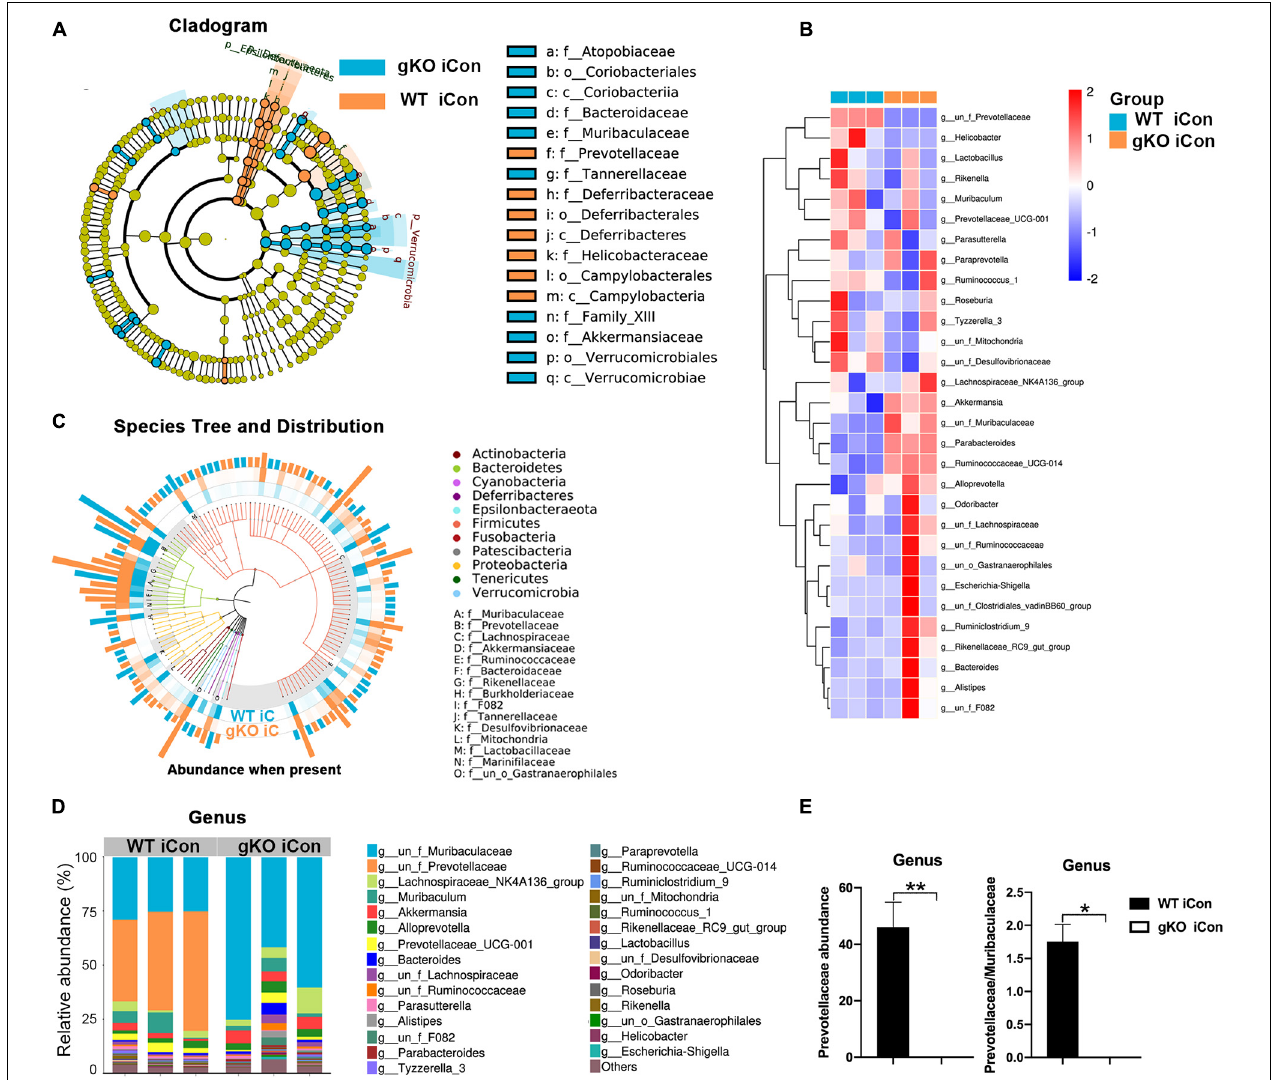
FIGURE 5 | Dysbiosis of gut microbiota in global Rgmb knockout mice at the inflammatory stage of CAC. (A) The cladogram of evolution relationship between gut microbiota from heterozygous global Rgmb knockout (Rgmb ± ) and wildtype (Rgmb + / + ) mice at the inflammatory stage of CAC. (B) Heatmap on the relative abundance of gut microbiota from global Rgmb knockout and control mice at the inflammatory stage of CAC. (C) The species tree and distribution of gut bacterium at species level. (D) The relative abundance of gut microbiota at genus level. (E) The relative abundance of Prevotellaceae (left panel) and the ratio of Prevotellaceae to Muribaculaceae (right panel) at genus level. * P < 0.05 and ** P <